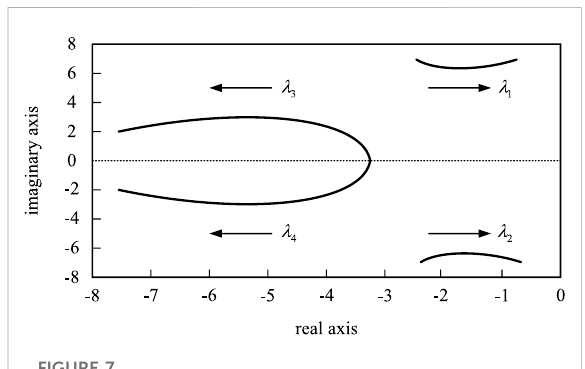
FIGURE 7 The root locus of the characteristic equation of the